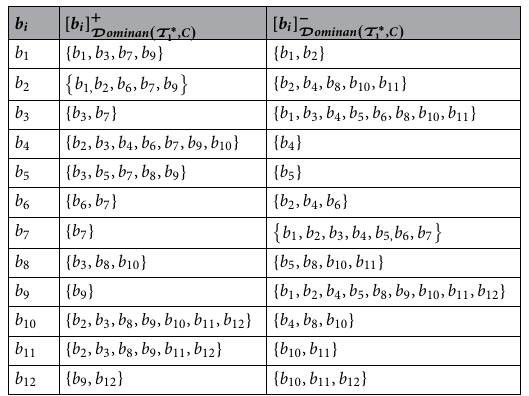
[ b i ] − D omian ( T ∗ C ) 1 ,